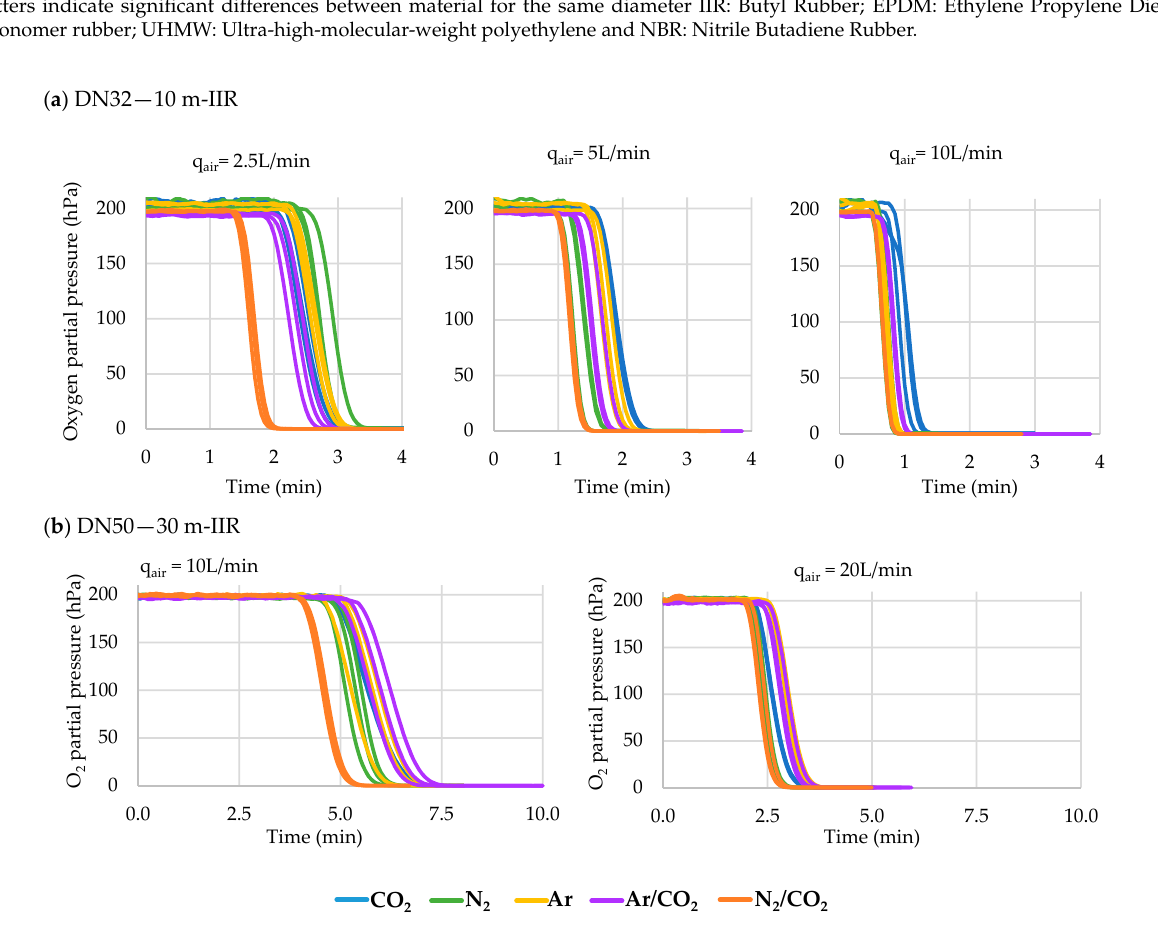
Figure 5. Time needed to purge the air from the interior of IIR hoses with different inert gases at different flow rates (10 L/min): ( a ) DN32 and 10 m length; ( b ) DN50 and 30 m length. The remaining measurements of the other hose materials are available in the Supplementary materials Figures S1 and